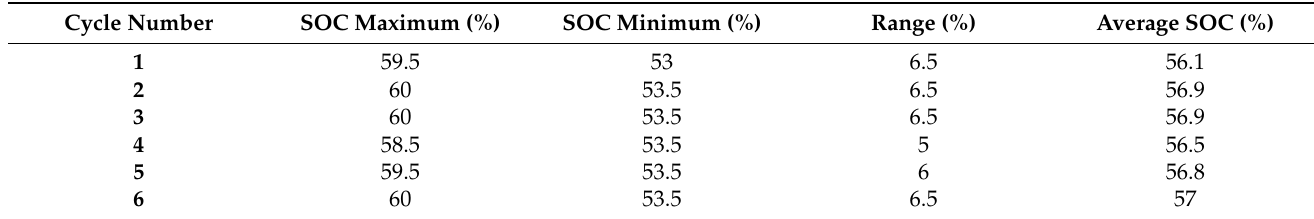
Table 6. Power battery SOC of vehicle A under six consecutive CLTC-P conditions.